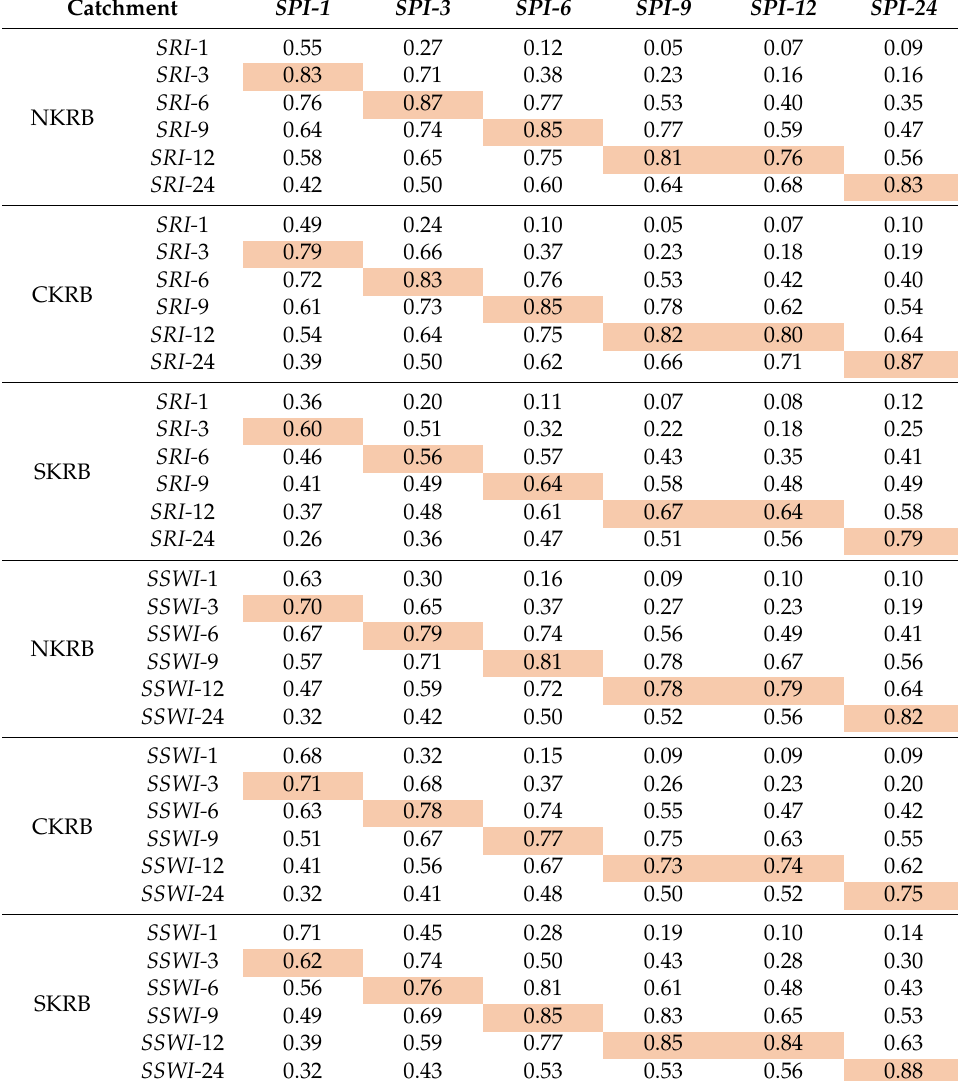
Table 4. Correlation coefficient of SPI with SRI and SSWI in different time scales and in three catchments; the highlighted boxes show the highest correlation values of SPI s with SRI s and SSWI